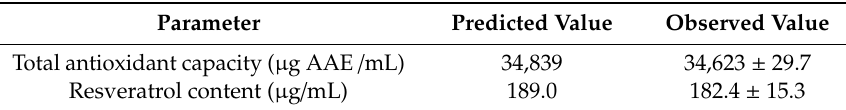
Table 6. Results obtained for optimal